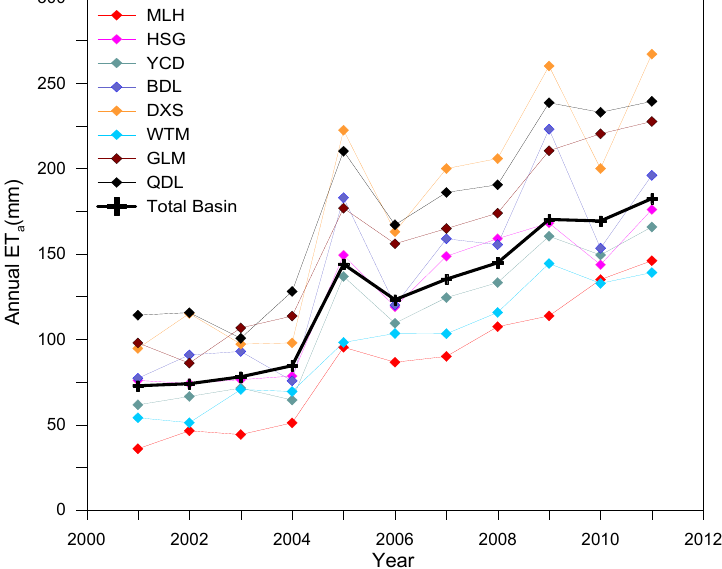
Figure 4. Variation of annual SEBS ET basin during the period of